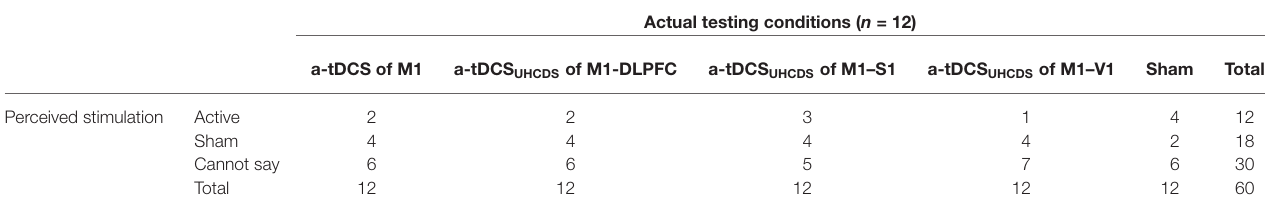
TABLE 3 | The judgements of participants on the stimulation